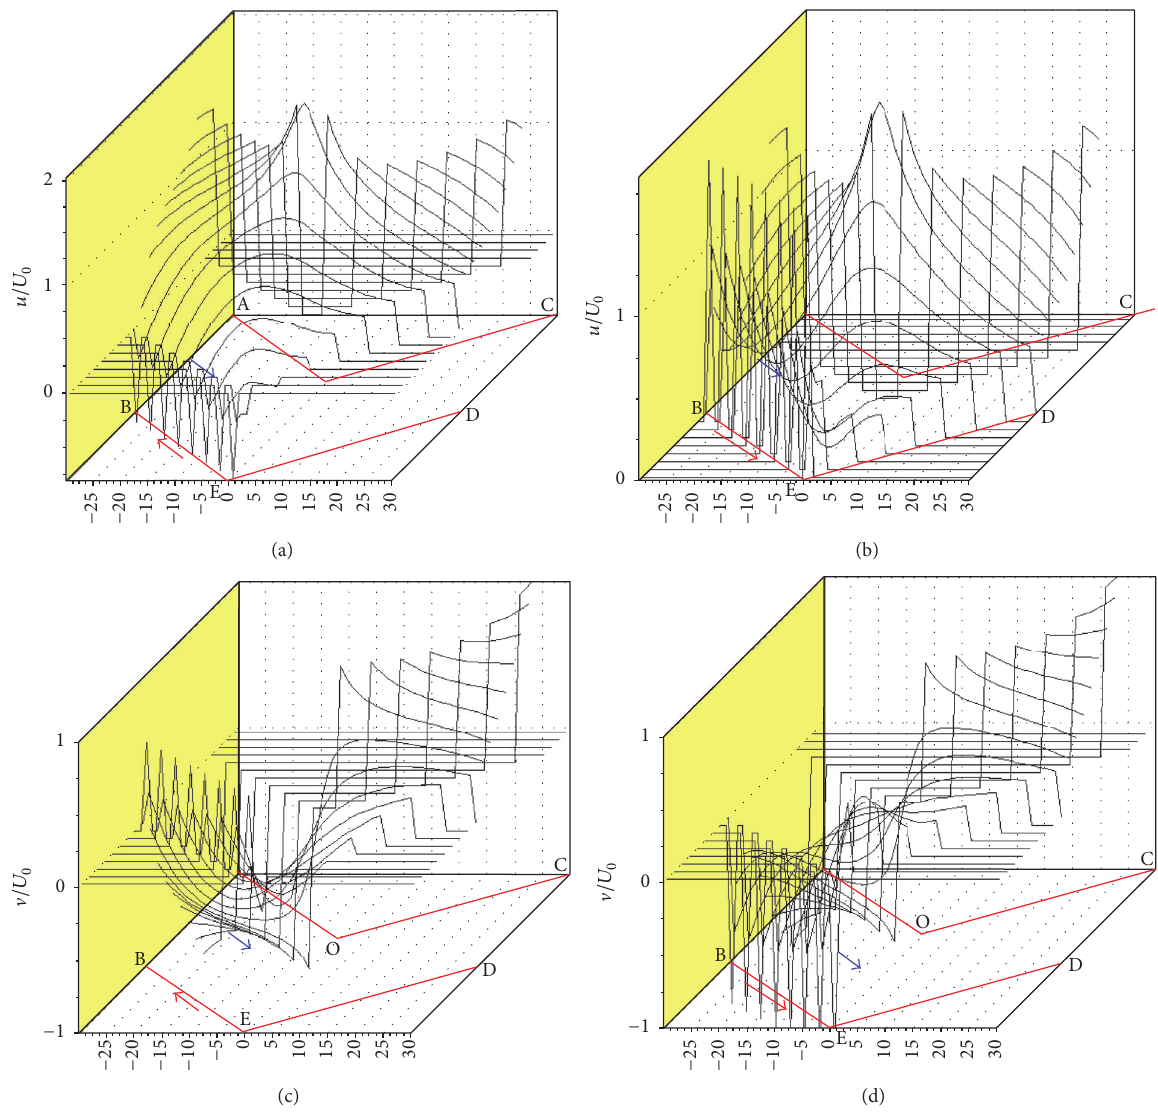
Figure 10: CFD-derived diagrams for the dimensionless 𝑥 -projection 𝑢 of the flow velocity 𝑤 (a, b) and for the dimensionless 𝑦 -projection V of the flow velocity 𝑤 (c, d) for a Segal die with channel intersection angles ∠ (AOC) = 2 𝜃 = 105 ∘ , where inlet die wall BE moves upstream towards the punching direction with velocity 𝑉 𝑤 = −𝑈 0 (a, c), inlet die wall BE moves downstream stream-wise with increased velocity = 2𝑈 𝑈 𝑉 𝑤 0 (b, d), 0 is punching velocity, and the dimensional transition times are 1.258 s (a, c) and 1.797 s (b, d). assuming that the initial solution points are chosen not near chosen several cells away from the AB